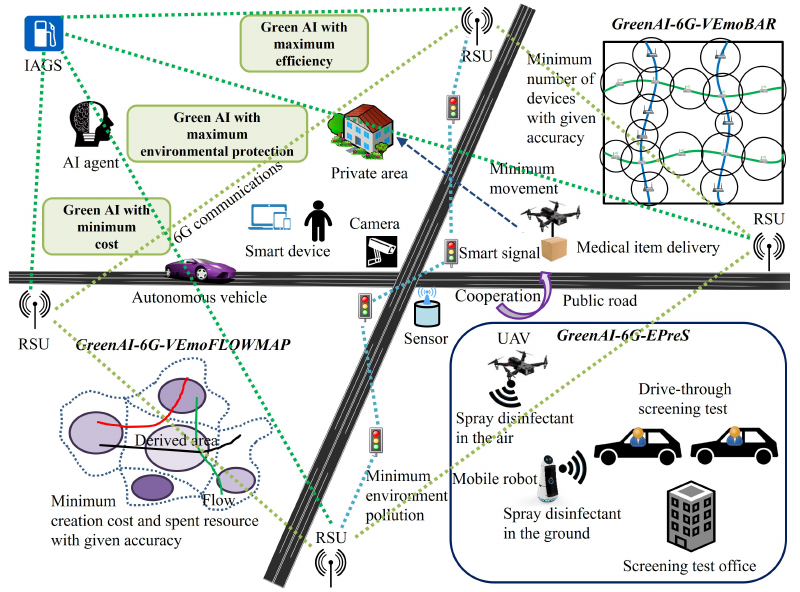
Figure 5. A description of applications with main components, operations and objectives including GreenAI-6G-VEmoBAR , GreenAI-6G-VEmoFLOWMAP , GreenAI-6G-EPreS with Green AI